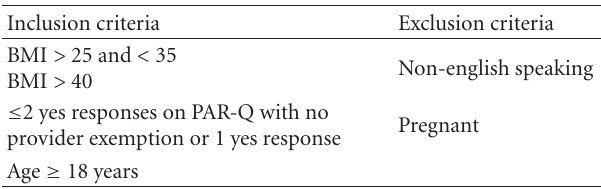
Table 1: Study inclusion and exclusion